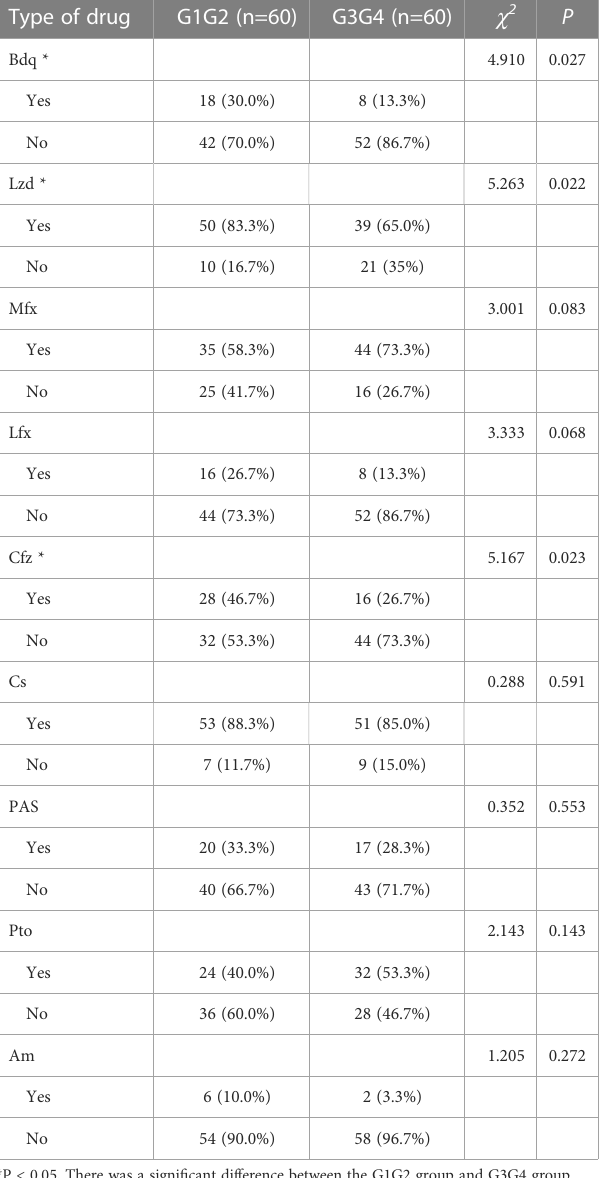
TABLE 2 Second-line anti-tuberculosis drug use in patients in the intensive and consolidation treatment groups. Type of